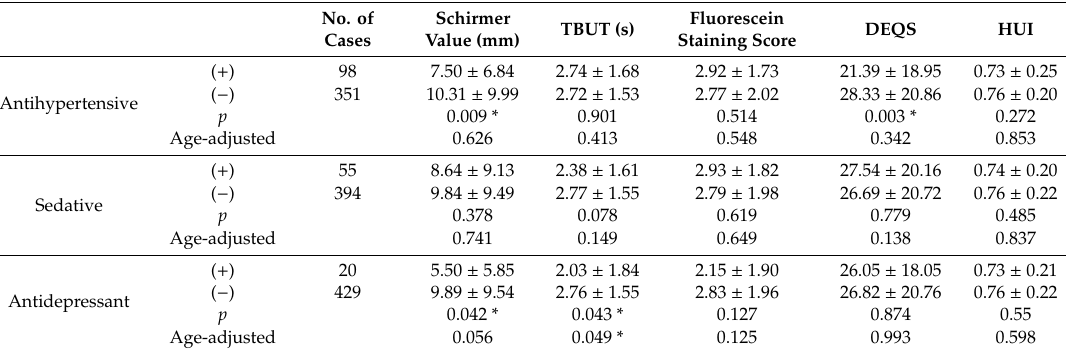
Table 4. Oral medicine and dry eye parameters.